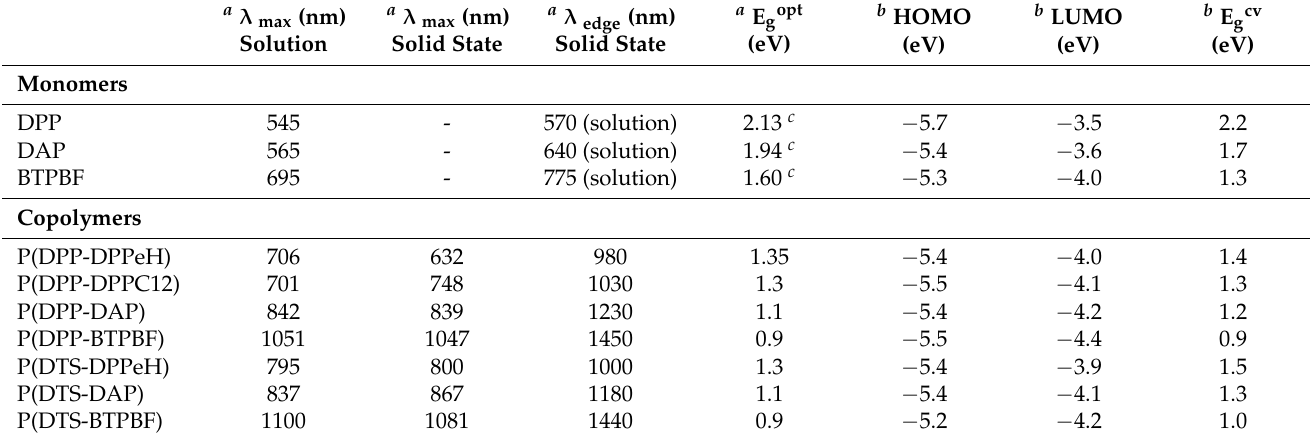
Table 2. Optoelectronic characteristics for monomers and